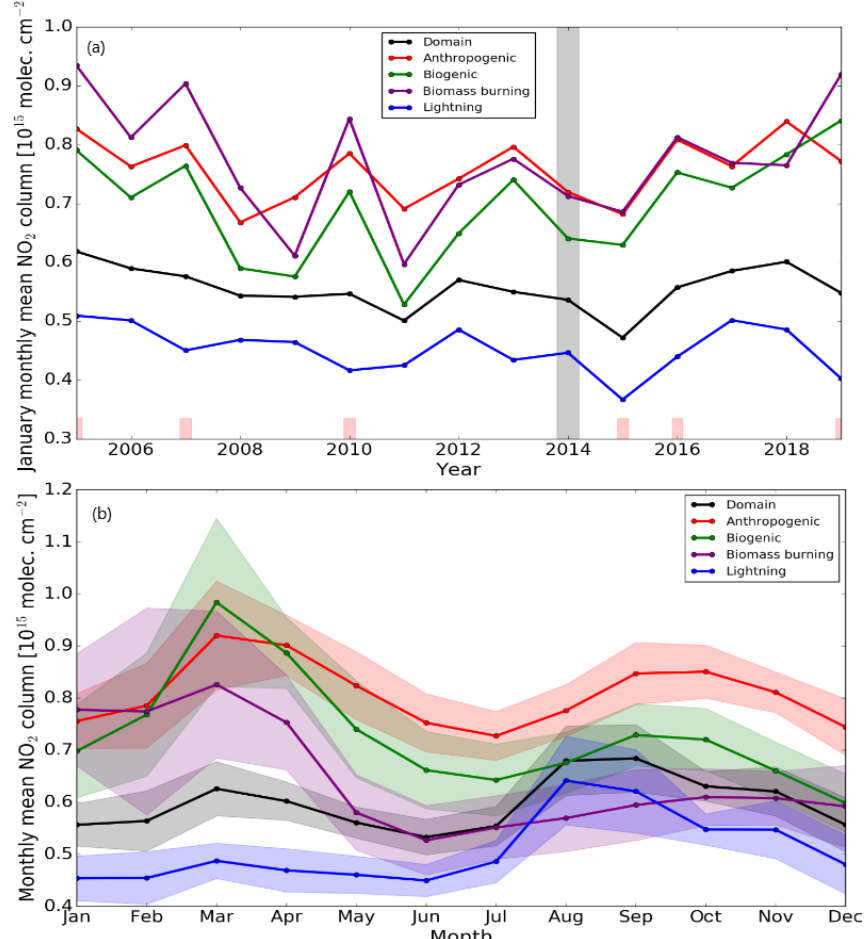
Figure 8. (a) January’s monthly averaged NO 2 vertical column densities (10 15 moleculescm − 2 ) retrieved from OMI for 2005–2019 for the whole domain (black), regions with dominating anthropogenic (red), biogenic (green), biomass burning (yellow) and lightning (blue) emissions. The gray vertical bar highlights the WRF-Chem simulated year 2014. The red bars indicate El Niño years (2005, 2007, 2010, 2015, 2016 and 2019). (b) Monthly averaged OMI NO 2 vertical column densities (10 15 moleculescm − 2 ) for 2005–2019. The shadings indicate ± 1 standard